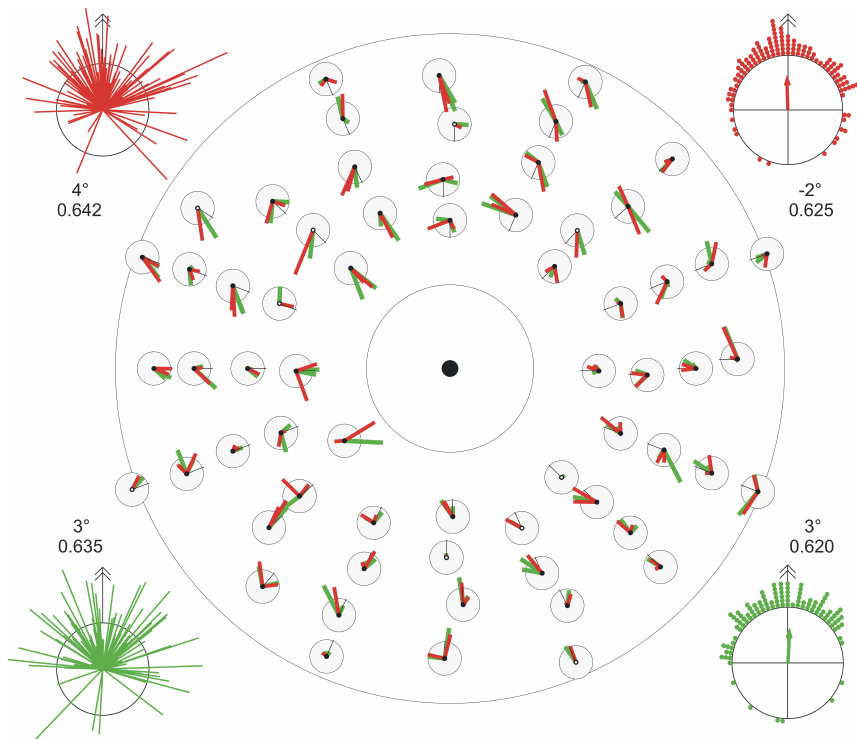
Fig. 2. Initial orientation vectors showing the results of the two most successful ItRuns (distinguished by colour) at 64 sites around the centre. Large diagram: radius of inner circle 50km, of outer circle 200km; north upwards. Radii of small circles at the different sites correspond to the median vector length of the whole sample (red or green, respectively; some vectors hidden by others). Two equally coloured vectors refer to the two chromatograms obtained in different years as available for most sites. If only one chromatogram could be used (<90% of 46 VOCs determined), only one vector is shown (central dot white). Large circular diagrams: all 118 α H values obtained at the 64 sites summarised, on the right the directions only (radius of circle = 1), on the left the complete vectors (radius of circle = median length = 1); numbers (and central arrows in the right diagrams) give direction and length of resulting mean vectors. Direction towards home is